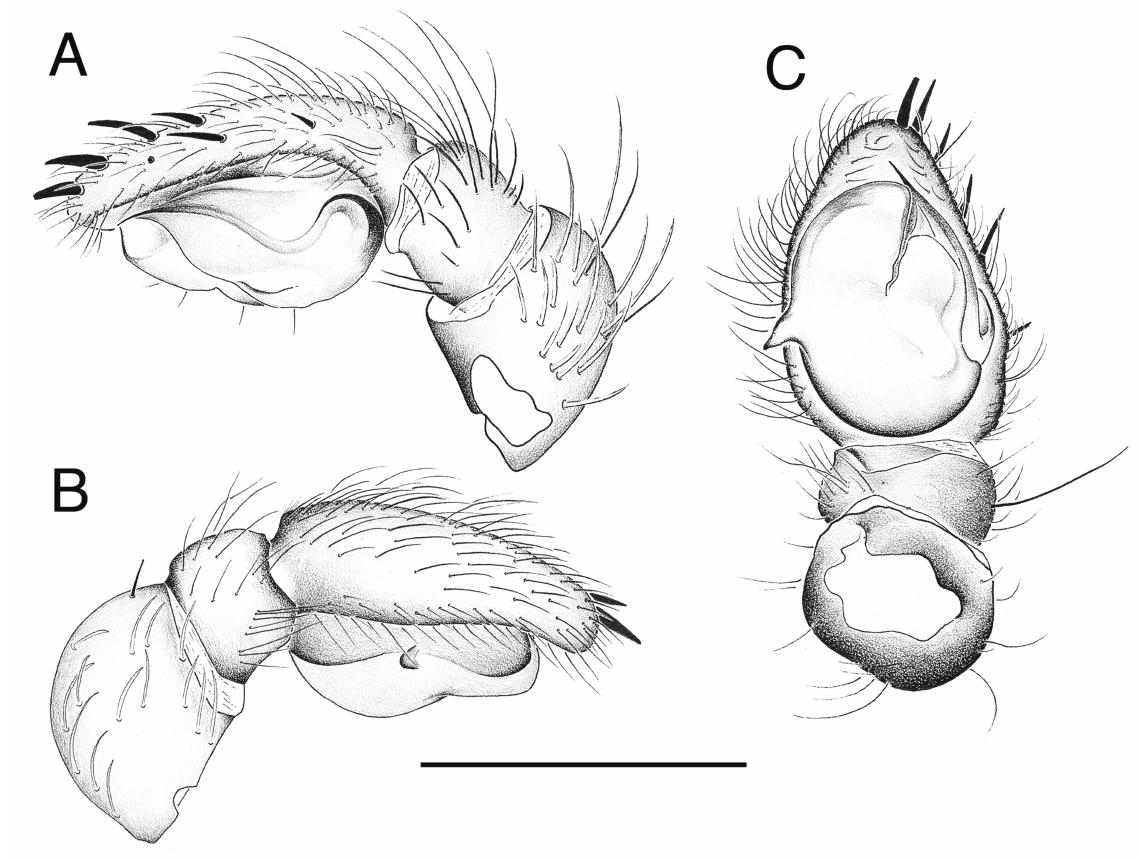
Fig. 15. Palindroma sinis gen. et sp. nov., holotype, ♂. A . Palp, prolateral view. B . Idem, retrolateral view. C . Idem, ventral view. Scale bar = 1